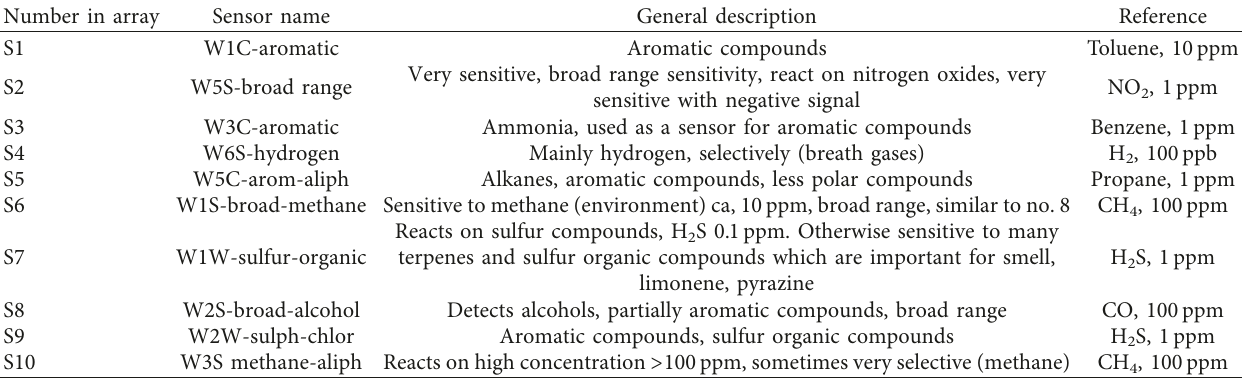
Table 1: Sensors used and their main applications in PEN 2 electronic nose. Number in array Sensor name General description